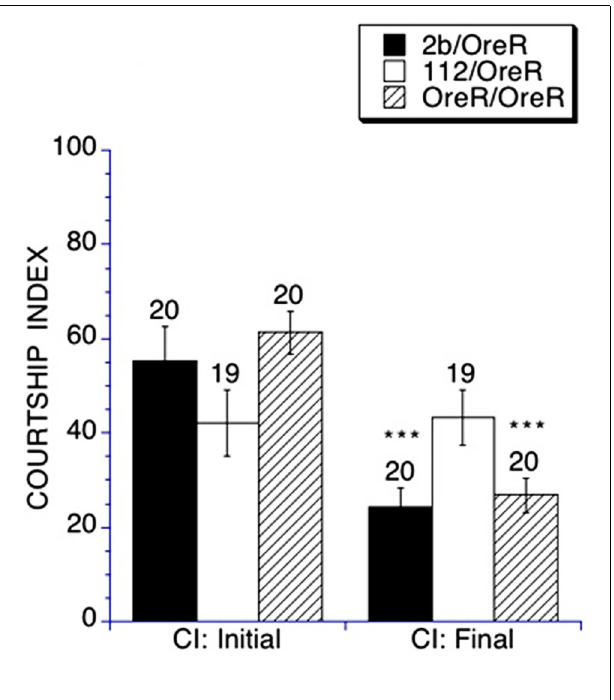
FIGURE 3 | Immediate-recall memory of conditioned courtship is impaired in heterozygous DmGluRA 112 mutant flies. Immediate-term memory was measured by placing a trained male in a holding chamber for 0–2 min after training, then subsequently placing him in a testing chamber with a virgin female target for a 10 min courtship interval.The resulting CI is compared to the CI obtained for naïve courtship. Mean CIs ( ± SEM) are plotted; Ns are indicated above each bar for all groups. For levels of significance, *** p < 0.001. Control DmGluRA 2b flies (filled black bars) and control OreR background flies (striped bars) exhibited intact immediate-recall memory as demonstrated by a significant depression of courtship activity in the trained versus the naïve groups.The DmGluRA 112 mutant flies (open bars) did not demonstrate a suppression of courtship activity after training and therefore had impaired immediate-recall